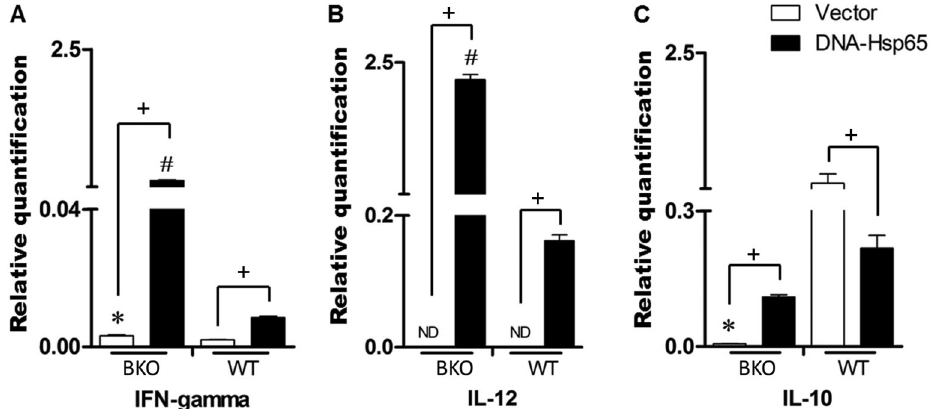
Figure 2. Relative expression of cytokine mRNAs in the spleens of wild-type (WT) and B-cell knockout (BKO) mice 30 days after immunization. C57BL/6 WTand BKO mice were injected intramuscularly on three occasions, at 15-day intervals, with 100 m g pcDNA3 encoding Mycobacterium leprae 65-kDa heat-shock protein (DNA-Hsp65 group) or with 100 m g empty pcDNA3 as a control (Vector group). Thirty days after the last immunization, the splenic gene pro fi les of A , IFN- g , B , IL-12, and C , IL-10 were evaluated with real-time qPCR. ND: not detected. * ,# P o 0.05: BKO immunized with DNA-Hsp65 or Vector vs WT immunized with DNA-Hsp65 or Vector; + P o 0.05: BKO or WT immunized with DNA-Hsp65 vs BKO or WT immunized with Vector (ANOVA, followed by Tukey ’ s